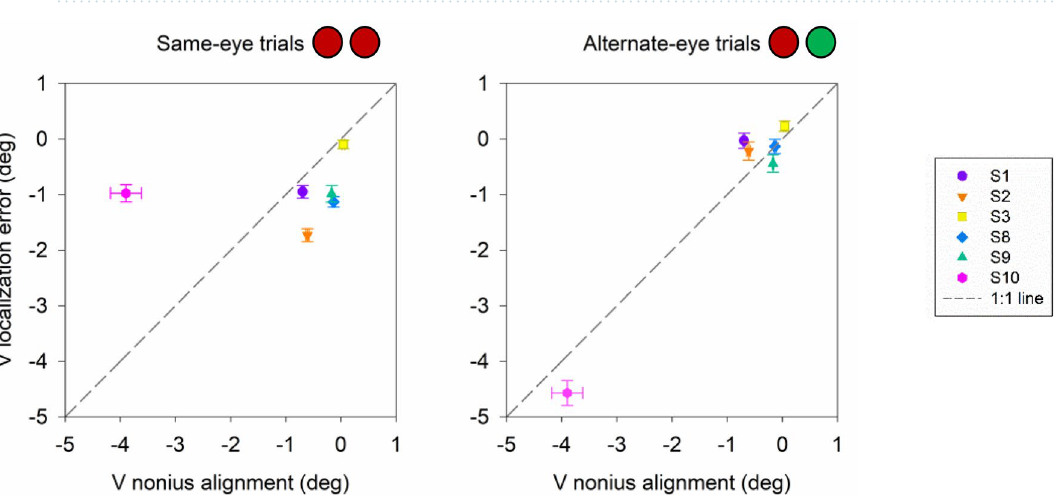
Figure 9. Scatter plot displaying correlation between vertical nonius alignment and vertical localization error (n = 6) for same-eye and alternate-eye viewing conditions. Color and shapes represent the mean and standard errors from individual subjects. Grey line is the 1:1